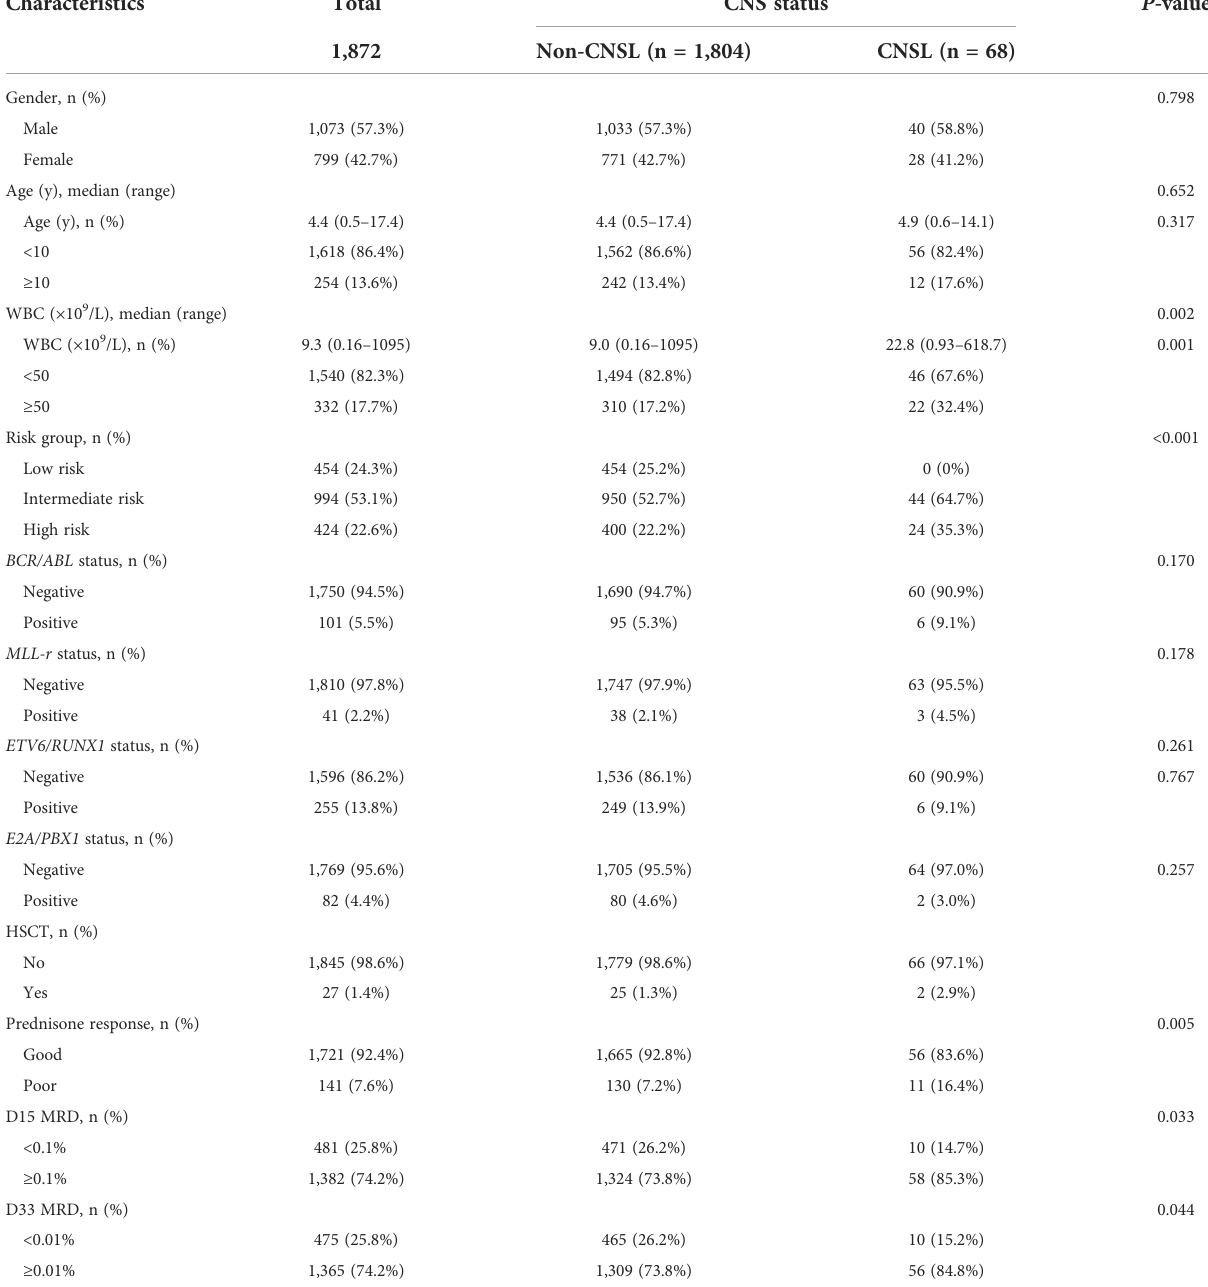
TABLE 1 Characteristics of childhood B-ALL with or without CNSL at